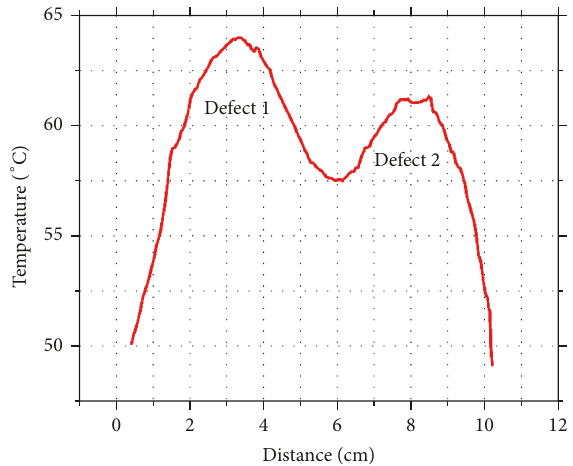
Figure 4: Temperature versus distance graph assigned to line 1 in Figure